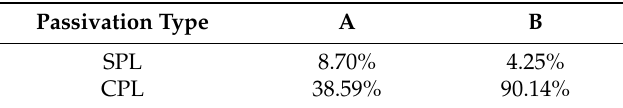
Table 2. Dependency of the magnitude on the type of passivation layer: A is the decreasing rate of the magnitude in the fat 1 tissue and B is the decreasing rate of the averaged magnitude between the fat 1 and fat 2